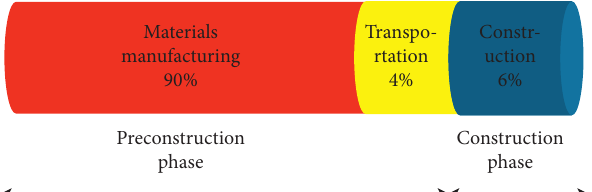
Figure 1: The embodied energy and emission by building